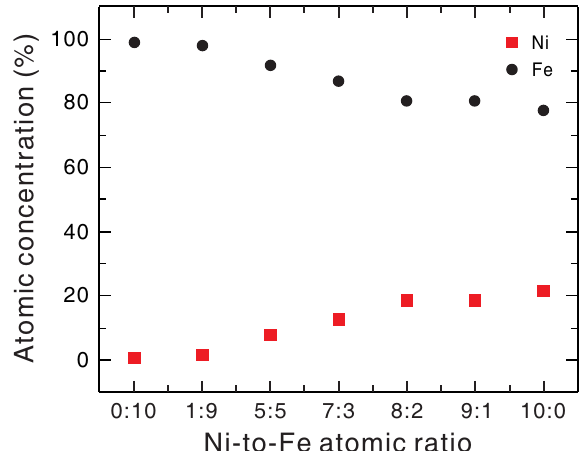
Figure 5. Ni and Fe atomic concentrations of Ni x Fe 1 − x O y /hematite photoanodes with various Ni-to-Fe ratios of the precursor measured with energy-dispersive spectroscopy (EDS), taking into account only Ni and Fe. The immersion time for depositing Ni x Fe 1 − x O y was 2